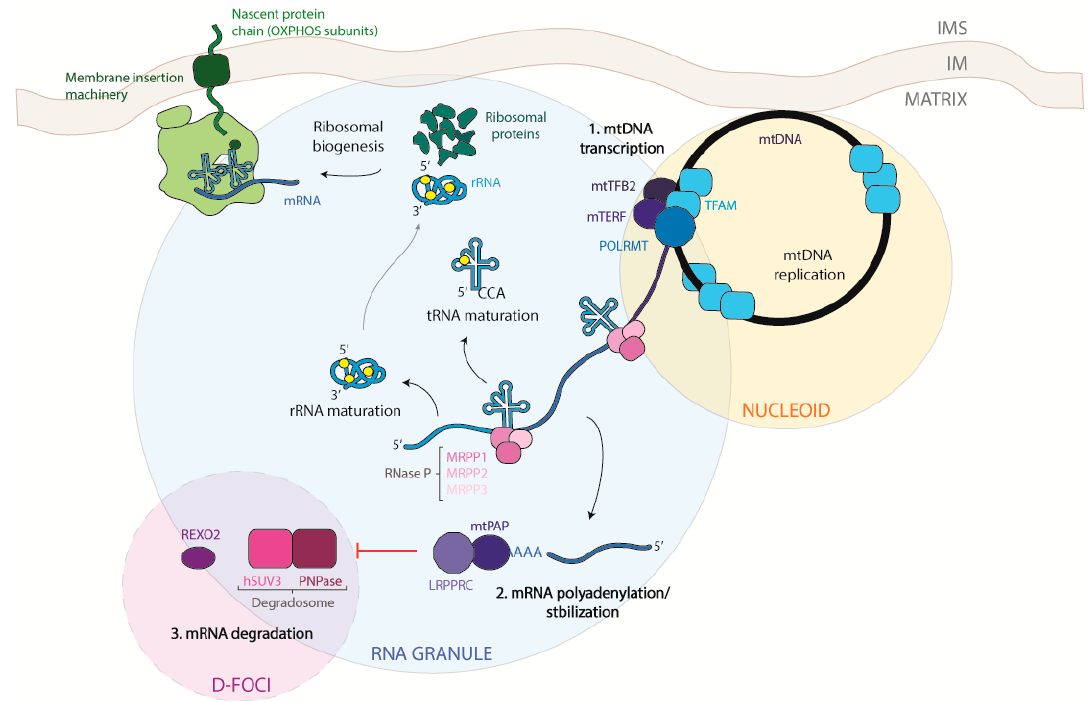
Figure 2. Schematic view of mitochondrial DNA transcription, RNA processing, and degradation. Mitochondrial DNA transcription takes place between nucleoids and mitochondrial RNA granules (MRGs). TFAM is the principal protein needed for the initiation of transcription as long as POLMRT, TFBM1, and TFBM2 ( 1 ). After transcription of the polycistronic molecules, RNA is immediately processed by RNASE P and Z to release tRNAs, following the tRNA punctuation model. Once tRNAs, mRNAs, and rRNAs are released, the translation process can start ( 2 ). mRNA degradation takes place in the D-foci, close to the MRGs. PNPase and hSuv3 are components of the degradosome. REXO2 isalso present in this compartment and degrades small RNA oligonucleotides ( 3 ). Black arrows: transitions; Red arrow: